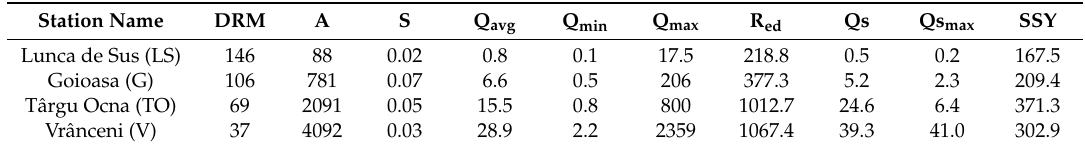
Table 1. Hydrologic parameters associated with each